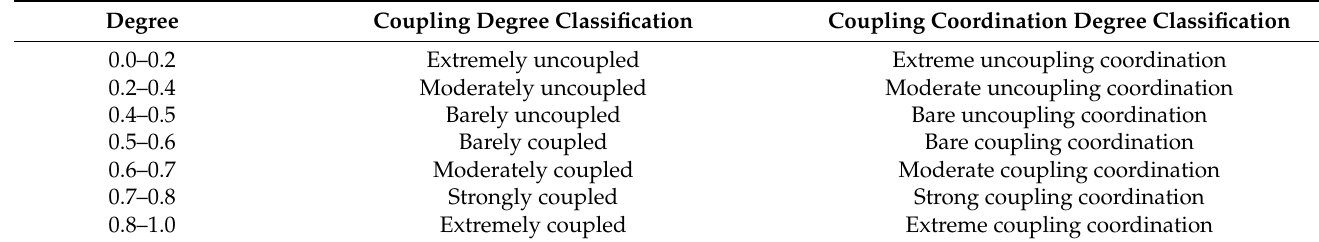
Table 7. Classification of coupling degree and coupling coordination degree.